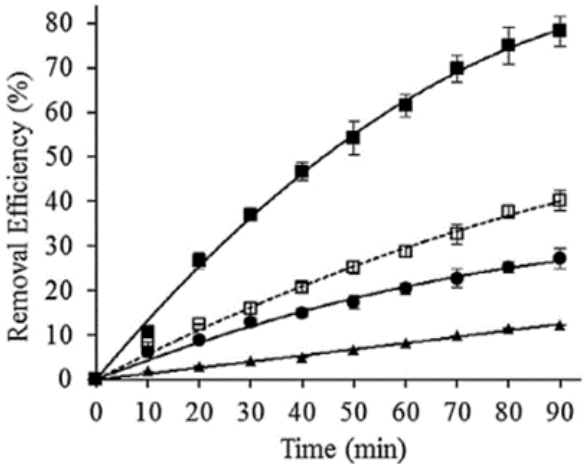
Figure 10. Degradation of 30 mg/L tetracycline in a 4.0 L solution following 90 min of (N) hydro- dynamic cavitation alone, (d) photocatalysis under circulation agitation, 100 mg/L TiO 2 , and (j) simultaneous photocatalysis and hydrodynamic cavitation, 100 mg/L TiO 2 . h is the simple linear sum of N and d (initial pH was natural 4.2; no matrix component was added). Reprinted with permission from [46].